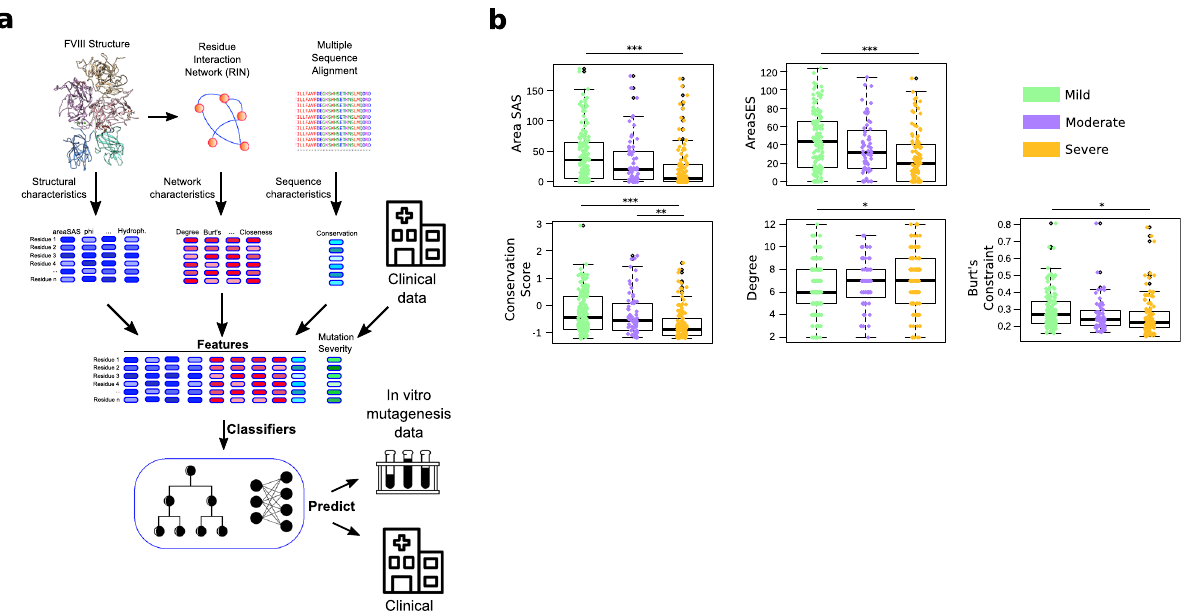
Fig. 1 Structural and nonstructural properties of the FVIII protein. a To assemble the dataset we combined structural properties from the FVIII protein structure, from a multiple sequence alignment (i.e., the conservation of residues), and from a residue interaction network (RIN). In a RIN, each amino acid is a node, and two nodes are connected if the two residues are at close proximity in the structure (i.e., if their main- or side-chains are less than ~5 Å from each other). The FVIII RIN had 1336 nodes and 4074 edges. b Distribution of values of the variables related to the HA severity. Depicted is the solvent-accessible (areaSAS) and the solvent-excluded (areaSES) surface areas, the conservation of the FVIII residues (conservation score — smaller values indicate higher conservation). The degree is the number of connections that a node has, and Burt ’ s constraint 21 quanti fi es the strategic location of a node between groups that would not be connected otherwise. The boxplots depict the median (centerline), the fi rst and third quartiles (lower- and upper-bounds), and 1.5 times the inter-quartile range (lower- and upper whiskers). Each dot in the plot is an amino acid mutation (i.e., a clinical case report). Statistics: one-way ANOVA followed by Tukey ’ s post hoc test. In all cases, we used n = 171 (mild), n = 70 (moderate), and n = 123 (Severe). *** indicate Tukey ’ s post hoc p values < 0.001; ** p value < 0.01; * p value <